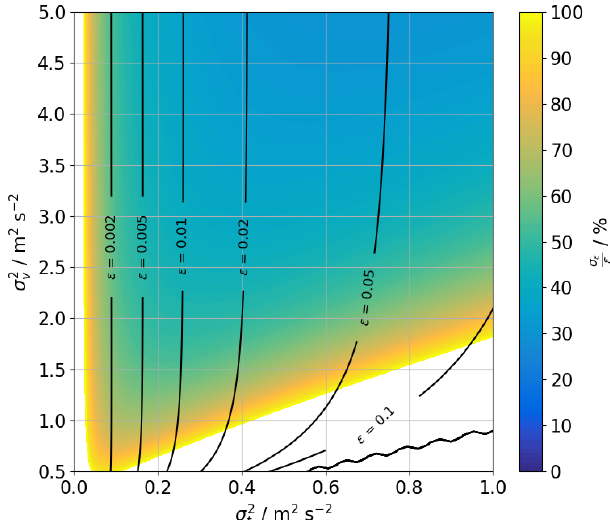
Figure 5. Uncertainty estimation for dissipation rate ε r depending on measured variances σ 2 v and σ 2 t . The contour lines show the as- sociated ε r